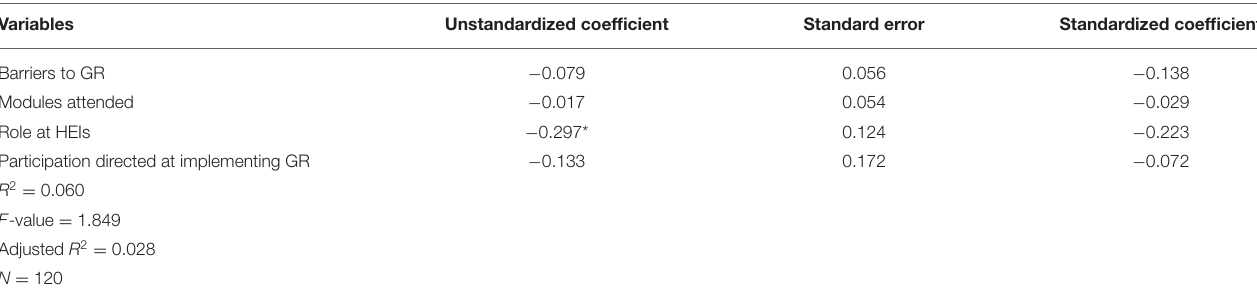
TABLE 4 | Results of regression analysis for barriers to GR on expected organizational change after GR